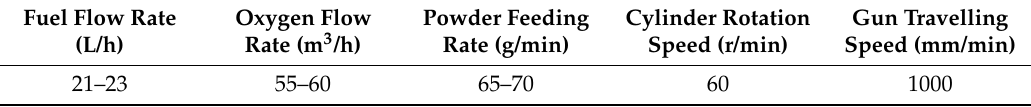
Table 3. High-velocity oxy-fuel (HVOF) spraying operation parameters.